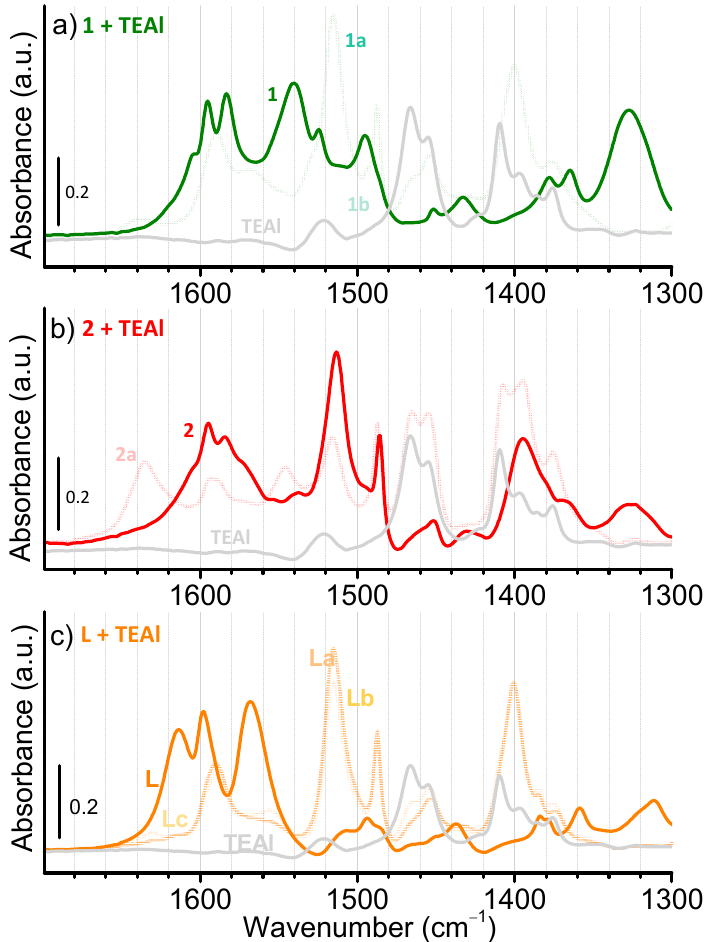
Figure 10. Evolution of transmission IR spectra of complex 1 ( a , green lines), complex 2 ( b , red lines), and ligand L ( c ) in the presence of increasing amounts of TEAl (10 µ L for 1a, 2a and La; 20 µ L for Lb, and 30 µ L for 1b and Lc). The spectra have been collected in chloroform solution at a concentration of 5 × 10 − 3 M, and the contribution of the solvent was subtracted from all the spectra. Also, the spectrum of neat TEAl is reported for comparison (grey line).